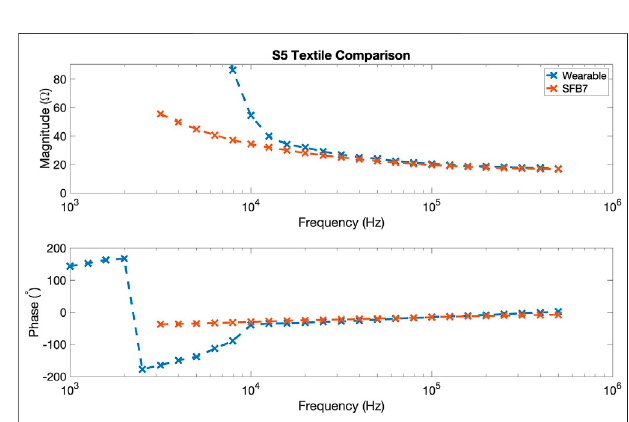
FIGURE9| BioimpedancemagnitudeandphasedataforS5(averageof 5 runs) showing the bioimpedance data that was unusable for fi tting due to high precision run to run. The magnitude data is zoomed in to show the slope of the SFB7 data; the wearable data goes up to about 900 Ω at 1 kHz. The high phase data for the wearable is where the system saturated the voltage rails; after this point both systems have negative but increasing phase rather than negative and decreasing phase from zero as in e.g., Buendia et al.